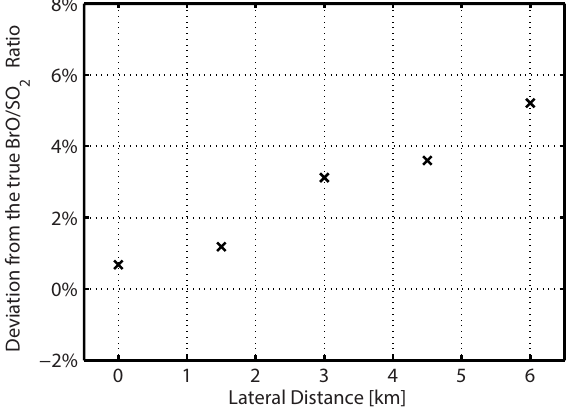
Figure 11. The influence of an increasing lateral distance between instrument and plume on the SO 2 and BrO CDs. For all calculations the volcanic plume was simulated 1.5km above the instrument. The SO 2 column densities were simulated at 320nm, the BrO column densities at 340nm.